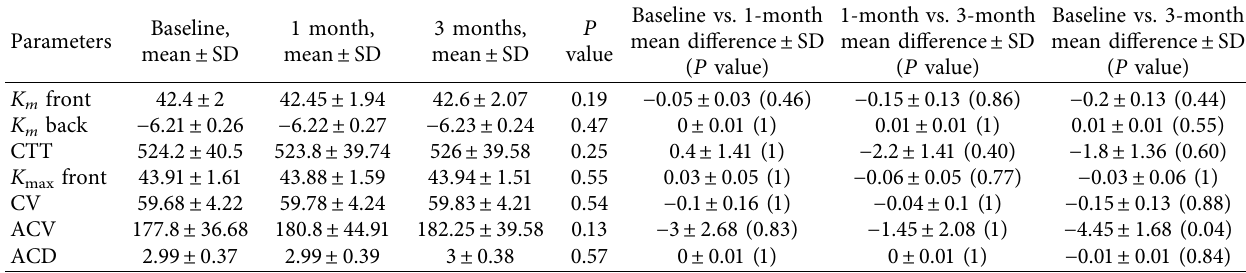
Table 1: Pentacam parameter mean values in different visits and comparison between different visits. SD: standard deviation; K keratometry mean front; K m back: keratometry mean back; CTT: cornea thinnest thickness; K max front: keratometry maximum front; CV: cornea volume; ACV: anterior chamber volume; ACD: anterior chamber depth.